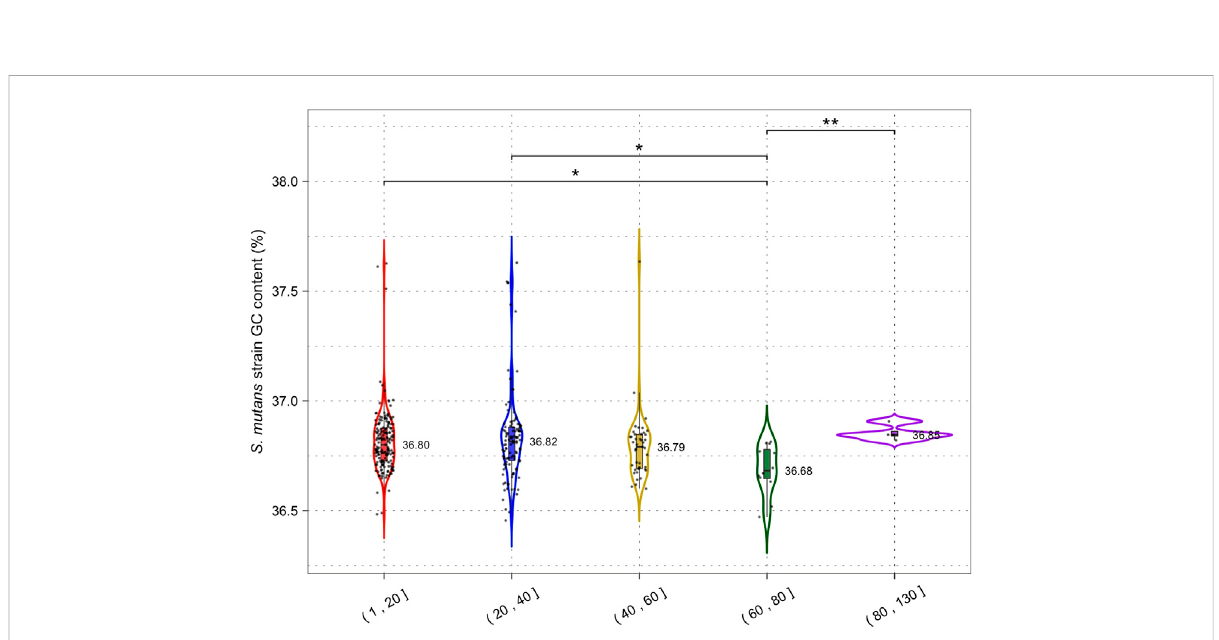
FIGURE 7 CRISPRactivityandGCcontent.GenomesweregroupedaccordingtothenumberofCRISPRspacerspresent(1 – 20,21 – 40,41 – 60,61 – 80and 81+) and a violin plot was generated for each group. Median GC content (percentage GC) is shown next to each violin plot; each dot is a single S. mutans strain/genome. Statistical signi fi cance between groups was calculated using a two-tailed t -test (* = p < 0.05; ** = p <